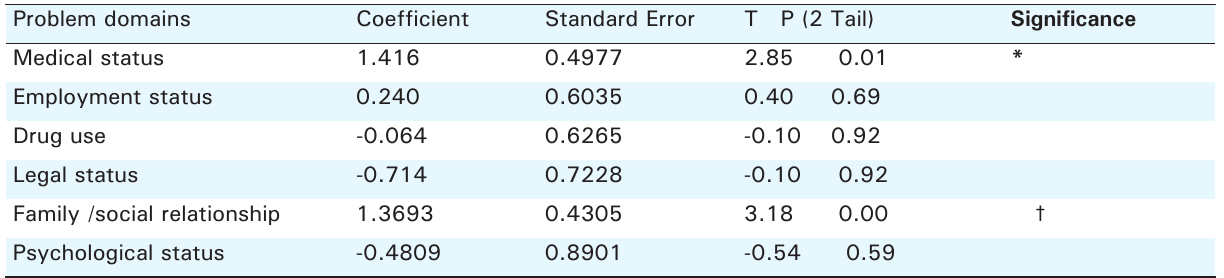
Table 10. Relationship between Family burden (total) score and each problem areas of Addiction Severity Index (ASI), (subjective severity)